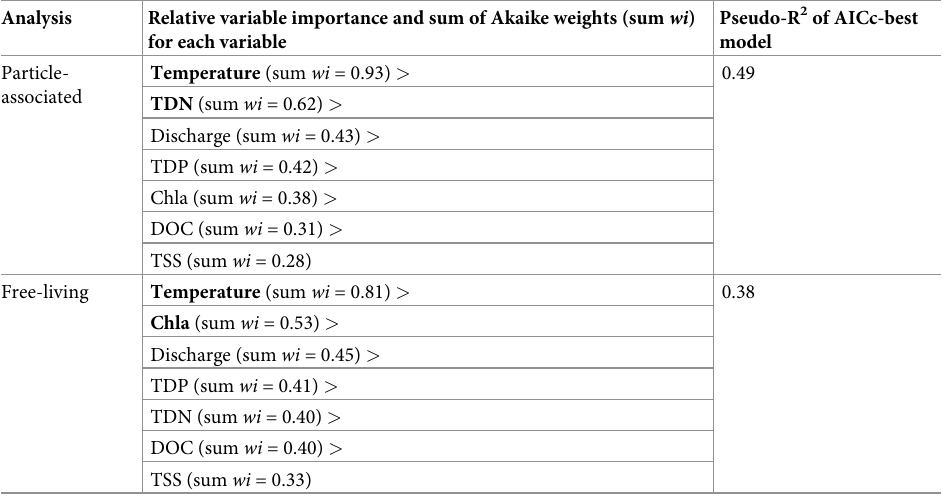
Table 2. Summary of results of relationships between variation in environmental variables and bacterial assem- blage beta diversity including relative importance of variables based on model selection using AICc (Akaike’s Information Criterion corrected for small